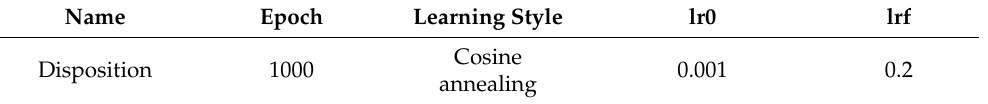
Table 3. Configuration table of learning parameters of the experimental model in this